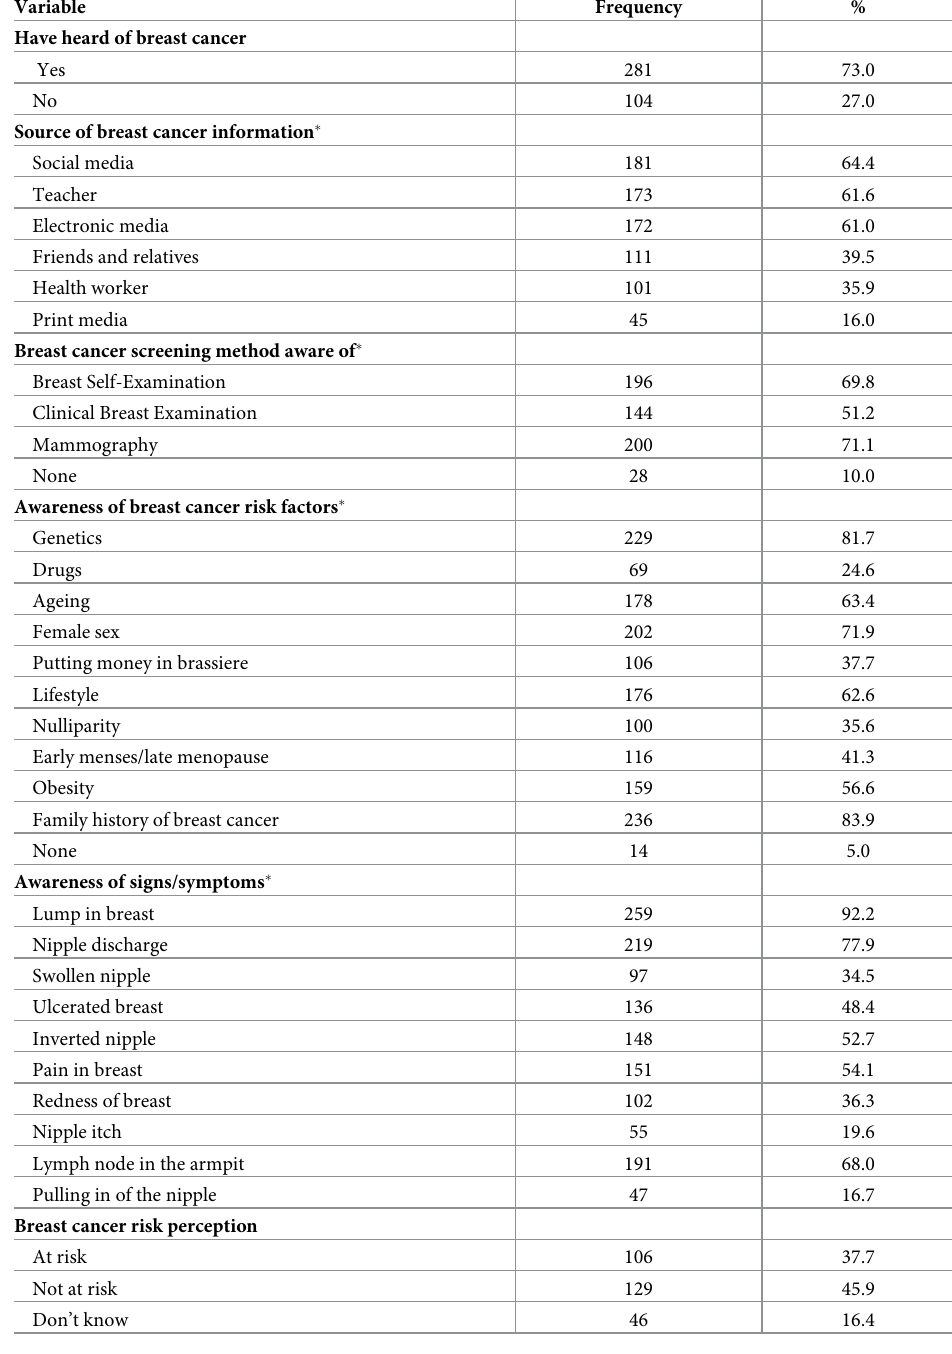
Table 3. Breast cancer awareness and risk